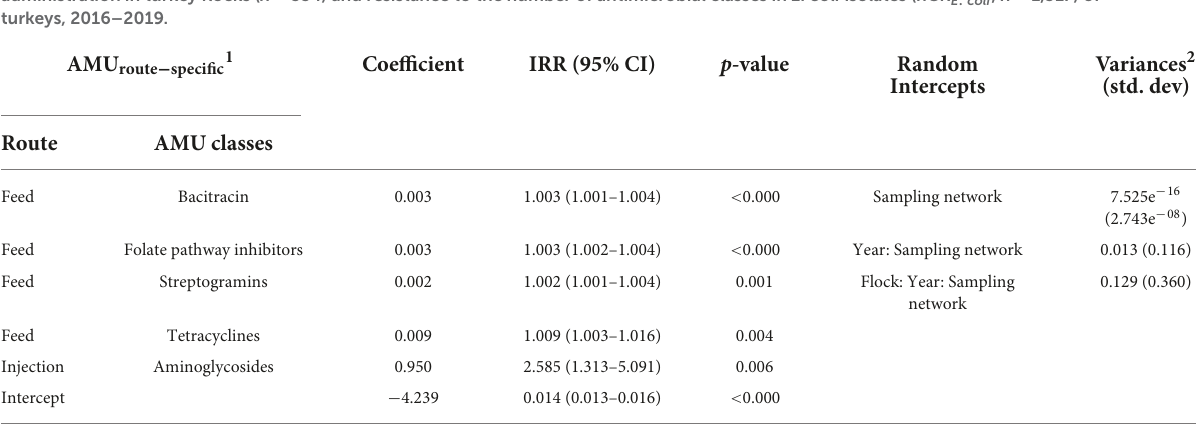
models that evaluated associations of individual class resistances and nCR E . coli with the use of any antimicrobial by a specific administration route (feed, water, or injection) to treat